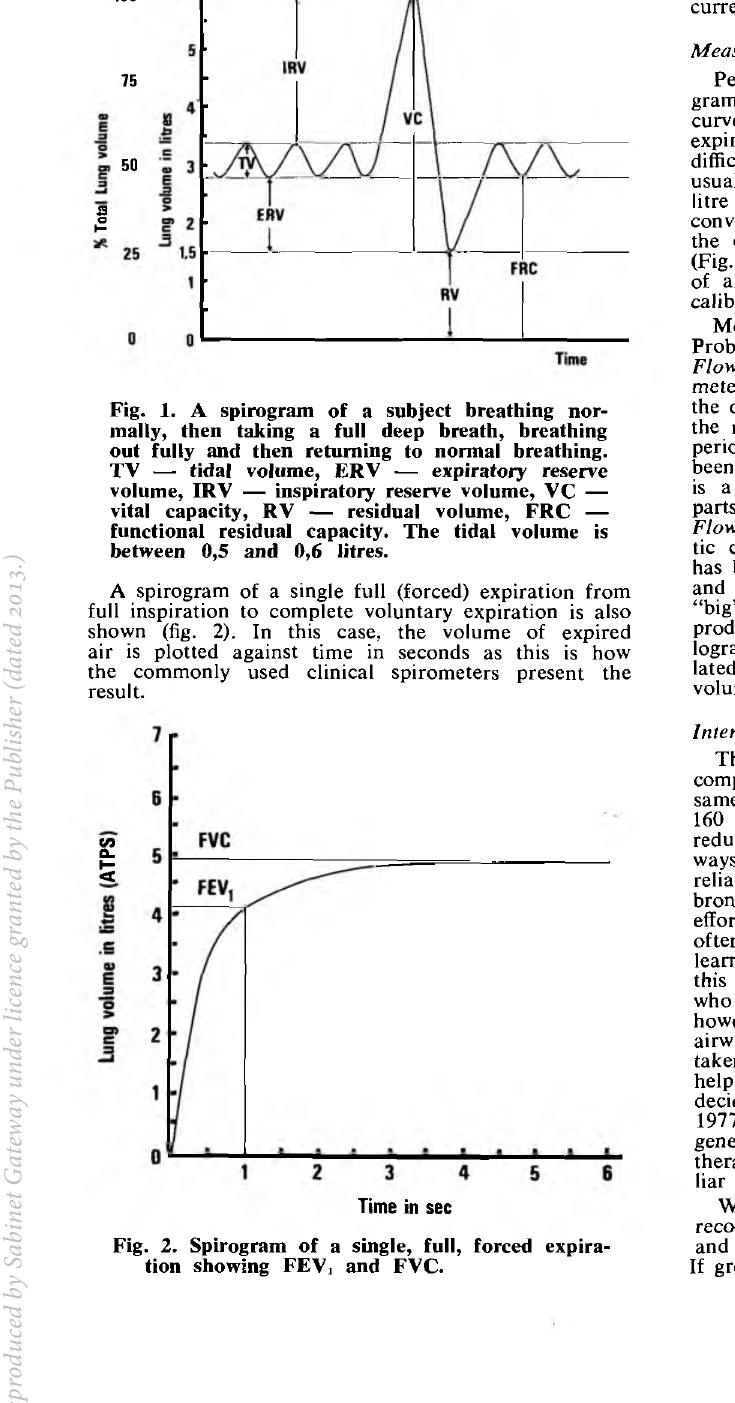
Fig. 2. Spirogram of a single, full, forced expira­ tion showing FEV, and